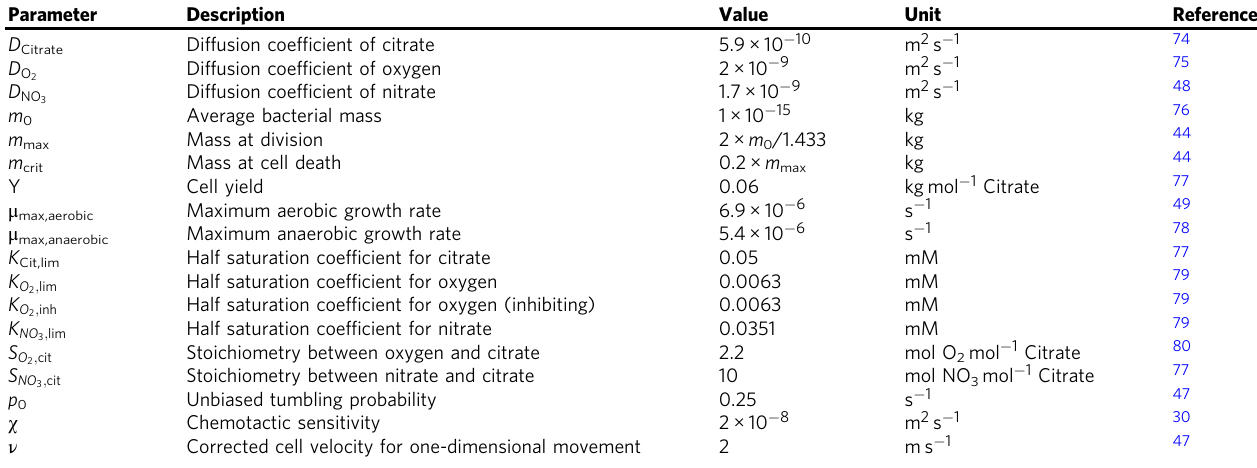
Table 1 Parameters used in the mathematical model and their source